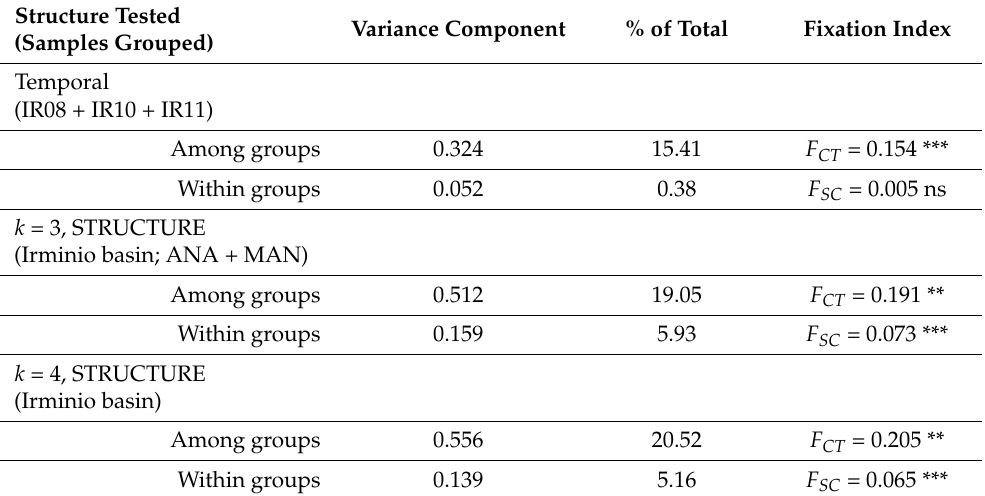
Table 3. AMOVA results of possible structures tested. Grouped samples are indicated in